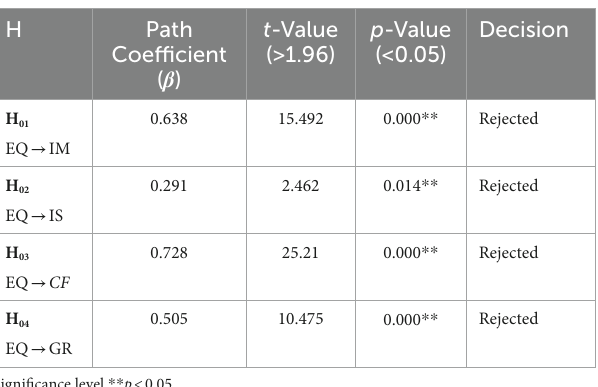
TABLE 6 The results of hypothesis